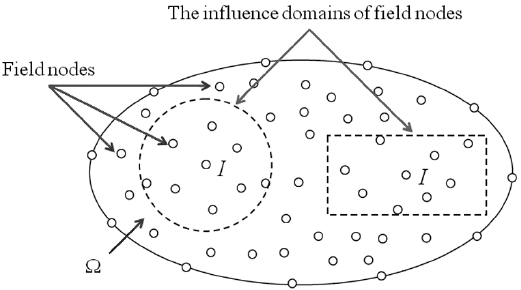
Fig. 1. Domain of influence.